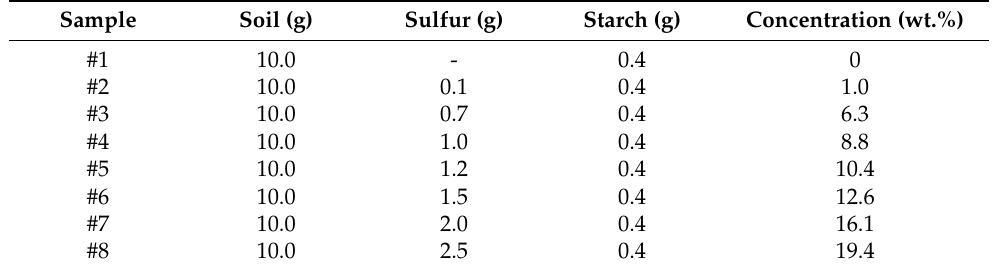
Table 1. Composition of the soil samples used for LIBS measurements in the VUV spectral region.